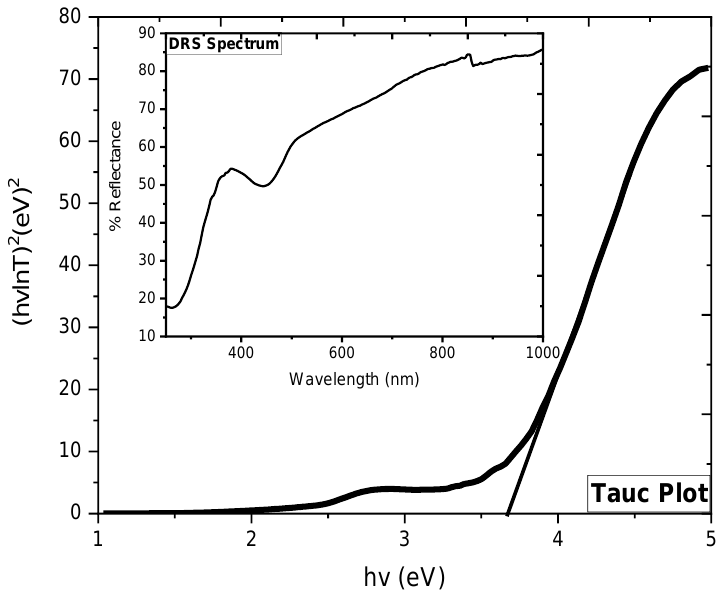
Figure 6. Tauc plot (inset: DRS spectrum) of SnO 2 NPs.